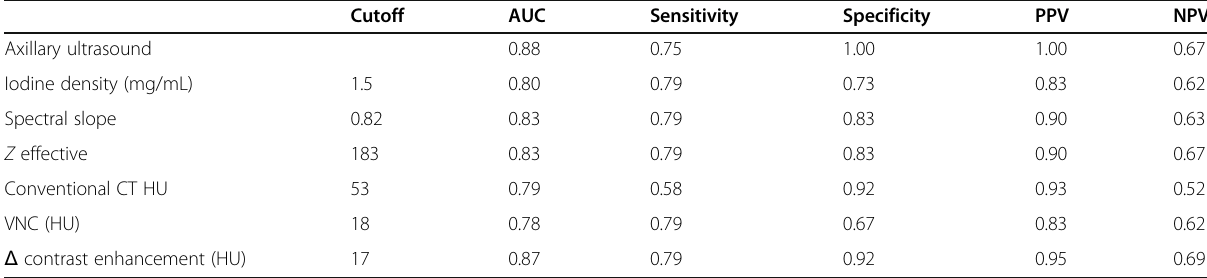
Table 4 Diagnostic performance for axillary ultrasonography and quantitative dual-layer spectral CT parameters for differentiating metastatic and non-metastatic axillary lymph nodes Cutoff AUC Sensitivity Axillary